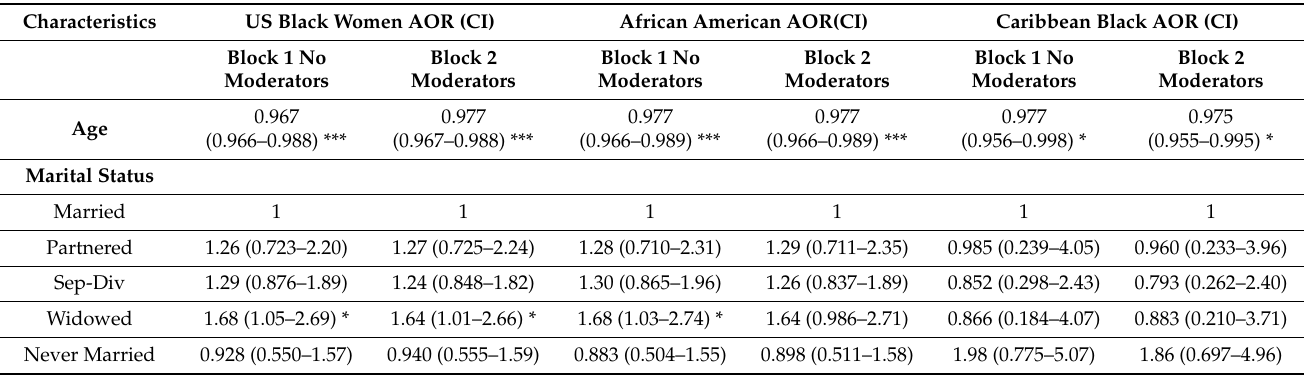
Table 3. Multivariate Analysis Examining IPV and Moderators on